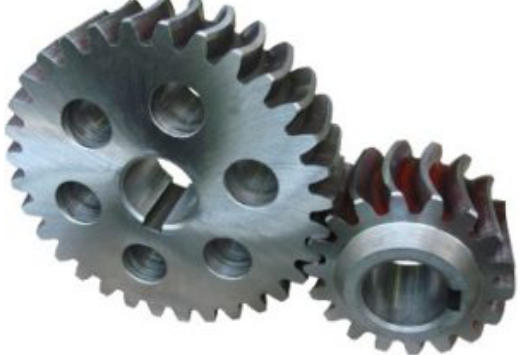
Figure 1. Arc teeth cylindrical